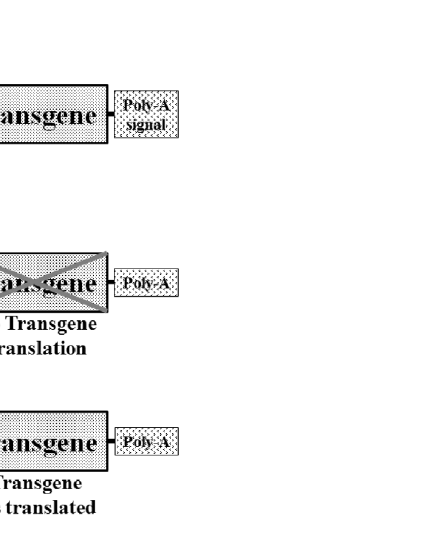
Fig. 1. A scheme of the construct design aimed at siRNA or miRNA induction of transgene expression. (A) The design on the DNA level. (B) The construct on the mRNA level following transcription, no transgene expression due to the inhibitory effect of the UIR. (C) The mRNA product following cleavage by siRNA or miRNA. The cleaved product that includes the transgene contains half of the target site (TS), the UIR is cleaved away, and the transgene can be translated.